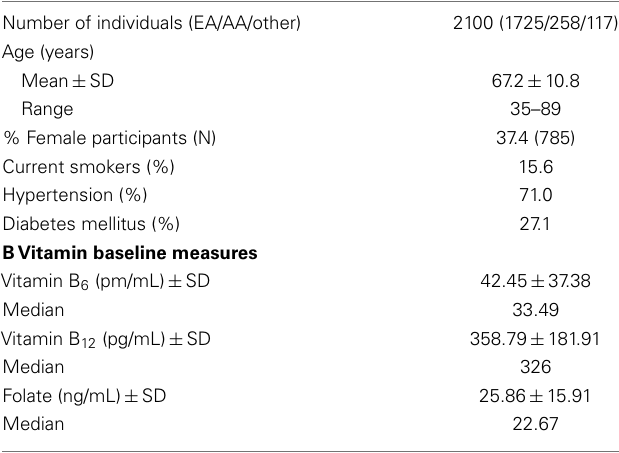
Table 1 | Demographic summary statistics